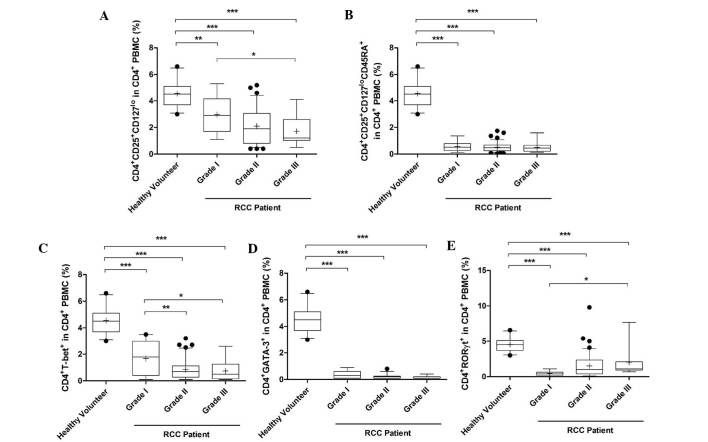
Proportion of Th1/Th2/Th17/Treg cells in different grades of RCC. (A) Proportion of activated Treg (CD4+ CD25+ CD127lo) cells reduced significantly in grades I-III of RCC compared with healthy volunteers. Furthermore, it reduced with increased grade and the proportion in grade III was significantly lower than in grade I. The percentages of (B) naïve Treg (CD4+ CD25+ CD127lo CD45A+) and (C) Th1 (CD4+ T-bet+) cells in grades I-III were also decreased and (C) the percentage of Th1 cells in grades II and III was significantly lower than that in grade I. (D and E) Percentages of Th2 (CD4+ GATA-3+) and Th17 (CD4+ RORγt+) cells in grades I-III were increased significantly compared with the healthy volunteers. (E) Percentage of Th17 cells was also increased in grade III compared with grade I. Data are expressed as the mean ± standard error of the mean. RCC, renal cell carcinoma; PBMC, peripheral blood mononuclear cell; Th, T helper cell; Treg, regulatory T cell; GATA3, GATA binding protein 3; RORγt, RAR-related orphan receptor γt. *P<0.05; **P<0.01; ***P<0.001.